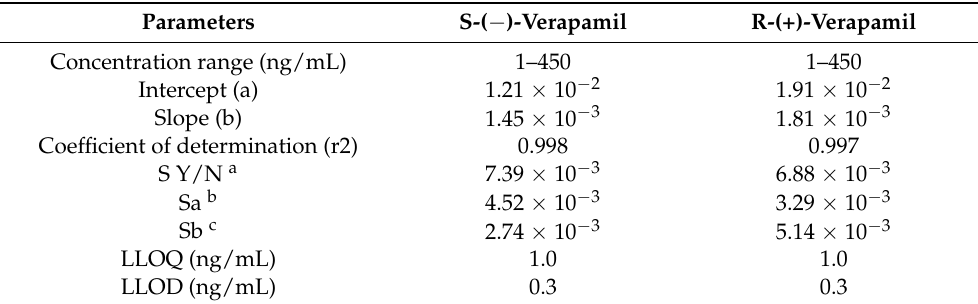
Table 3. Statistical parameters of calibration curves for S-( − )- and R-(+)-verapamil in rat plasma using the developed method.